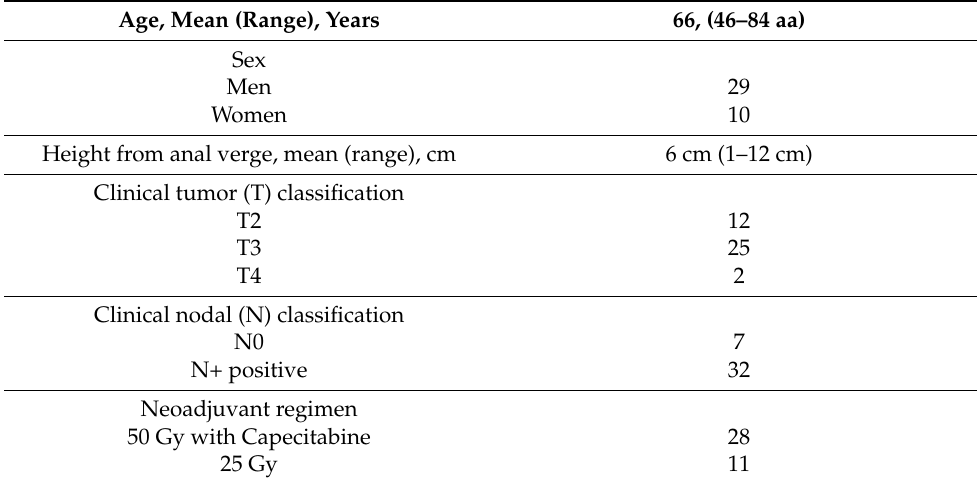
Table 1. Clinical and demographic characteristics of the W&W